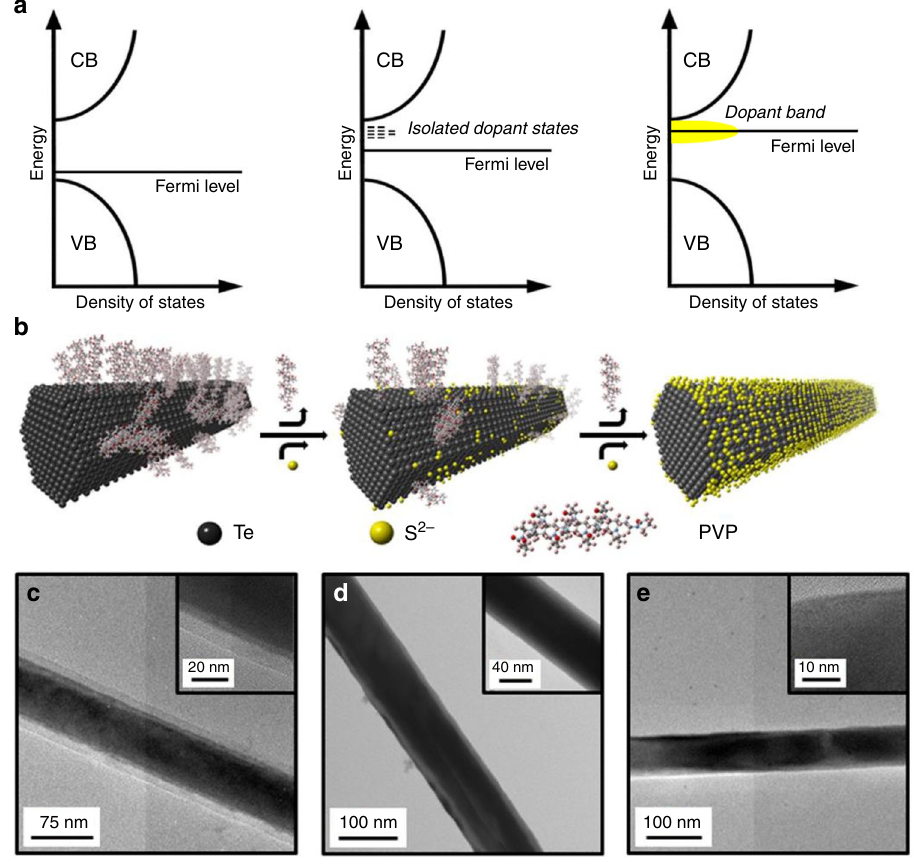
Fig. 1 Resonant band engineering by interfacial resurfacing. a , b Schematic of the doping process (not to scale) showing the evolution of the density of states and the change in Fermi level with removal of the polymer (polyvinylpyrrolidone, PVP) and attachment of the sulfur (S 2 − ) atoms. CB and VB stand for conduction band and valence band, respectively. At low sulfur concentration, isolated states originate close to the CB of tellurium which transform to a prominent sulfur-generated dopant band at high concentrations. c – e Transmission electron micrographs of undoped, intermediate- and heavily doped 80- nm diameter tellurium (Te) nanowires (NWs), respectively. The insets show high resolution images with both the inorganic component and the polymer layer. While one can observe a thick polymer layer in c , the doped sample in d shows a thinner layer and the one in e shows no evidence of any